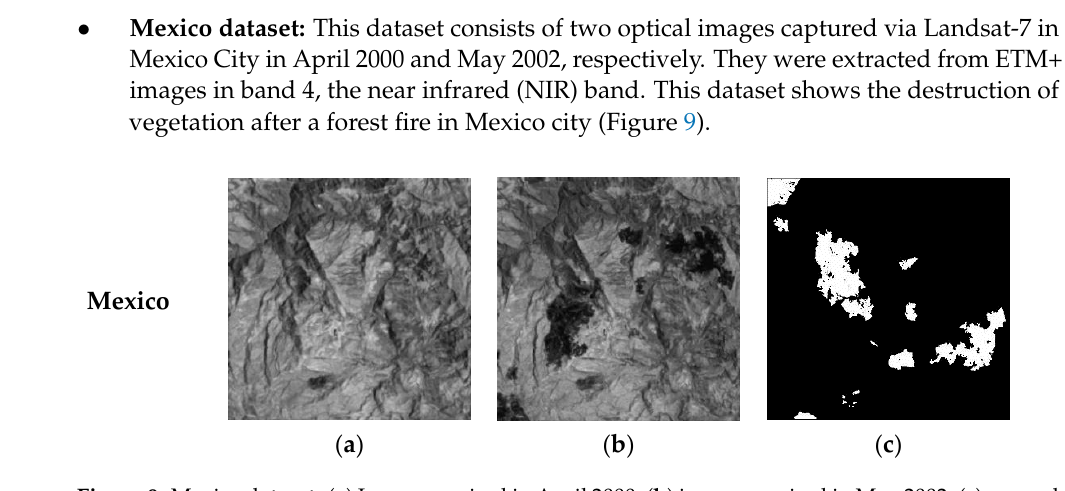
Figure 9. Mexico dataset. ( a ) Image acquired in April 2000; ( b ) image acquired in May 2002; ( c ) ground truth. Refer to Table 1 for more information about the experimental datasets. Table 1. Details of the experimental